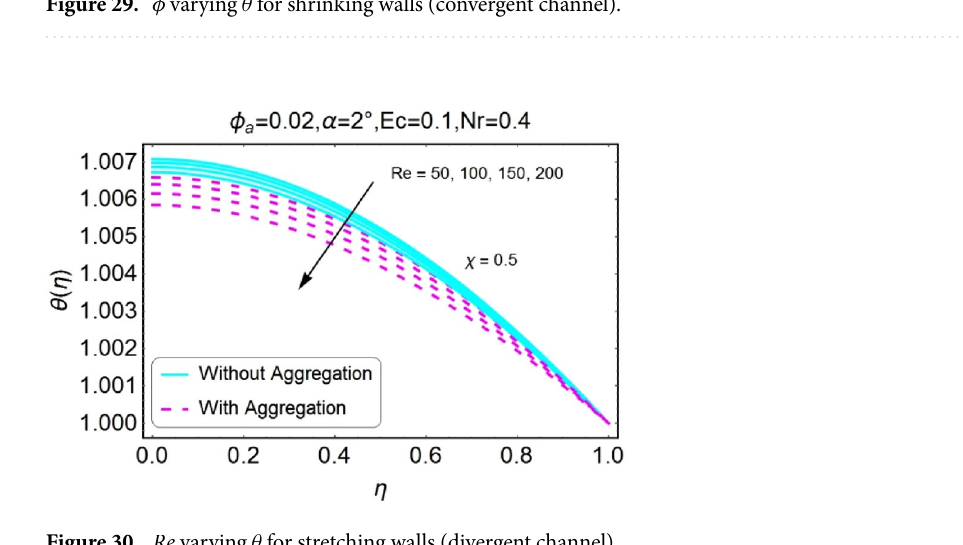
Figure 30. Re varying θ for stretching walls (divergent